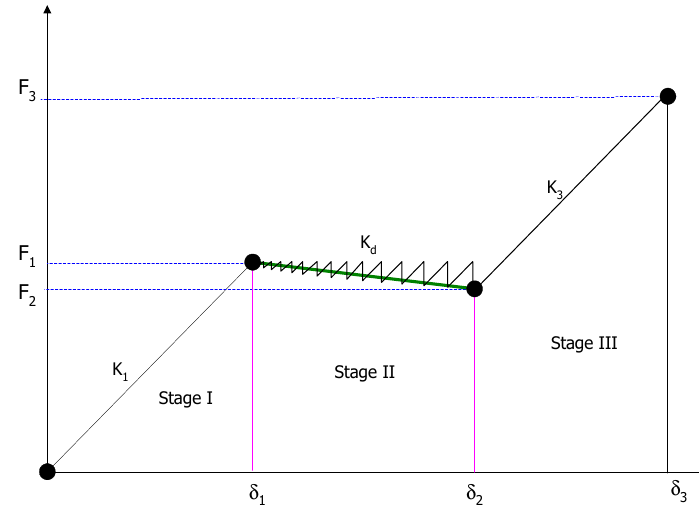
Figure 5. Approximation technique for tether response of an AWES.